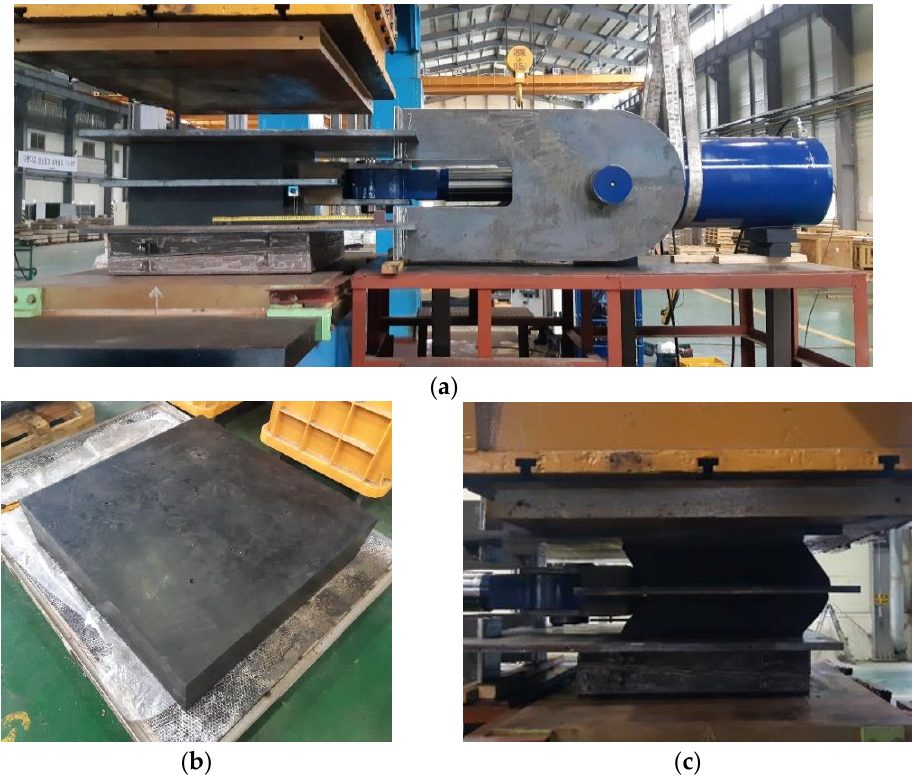
Figure 2. Test instruments and shear modulus test of elastomeric bearing specimen: ( a ) test instrument (2500-ton press and 300-ton horizontal actuator); ( b ) test specimen; ( c ) shear deformation of 100 mm (shear strain of 0.77).